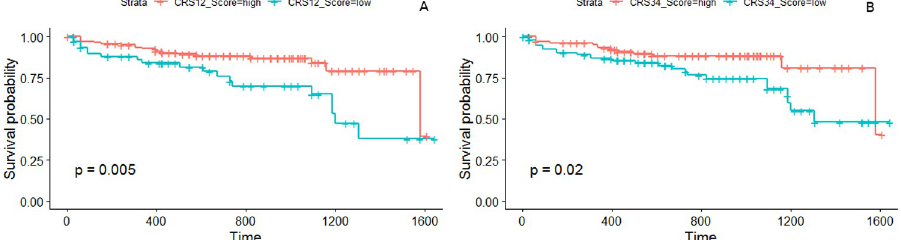
Fig 10. Survival analysis of combination biomarker panels shows significance. (A) Early-stage panel, CRS12; and (B) Late-stage panel, CRS34.